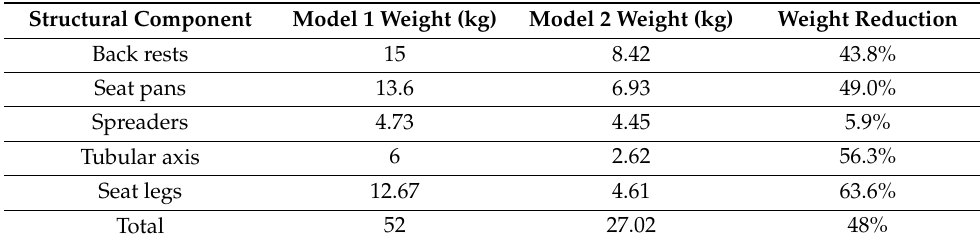
Table 14. Weight calculations for the assembly of the three-seat configuration